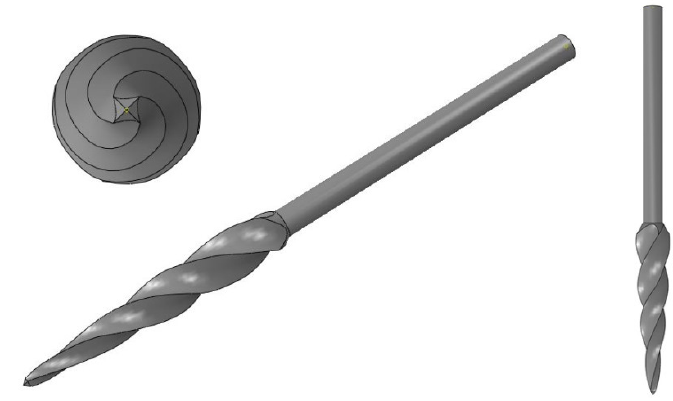
Figure 5. Screw point drawn using AutoCAD software.